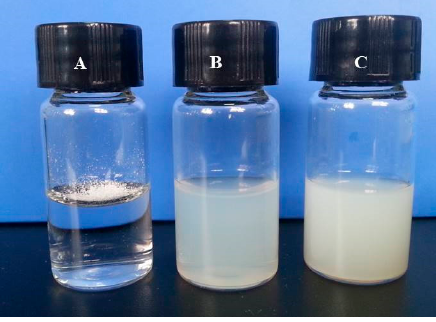
Figure 1. Photographs showing water solubility of ( A ) Albendazole (ABZ); ( B ) Blank solid lipid nanoparticles (BSLNs) and ( C ) Albendazole loaded solid lipid nanoparticles (ASLNs).